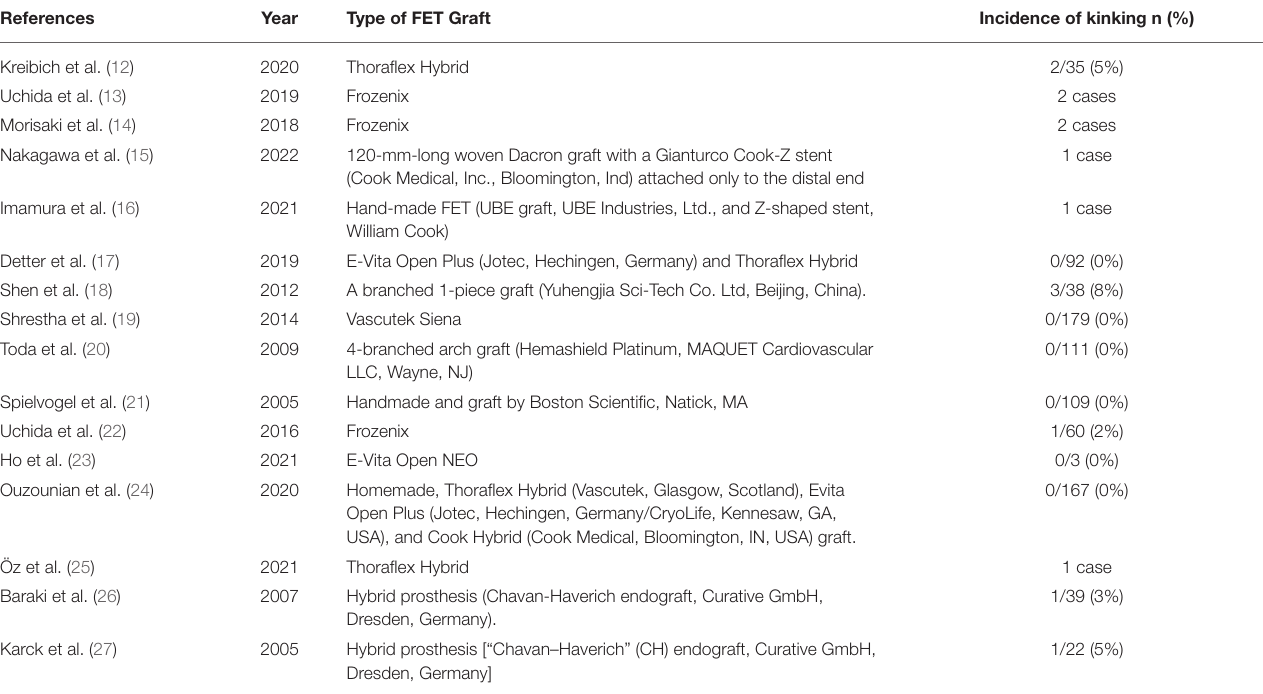
TABLE 1 | Overall summary of the studies reporting on FET graft kinking, the type of graft used, and the incidence of